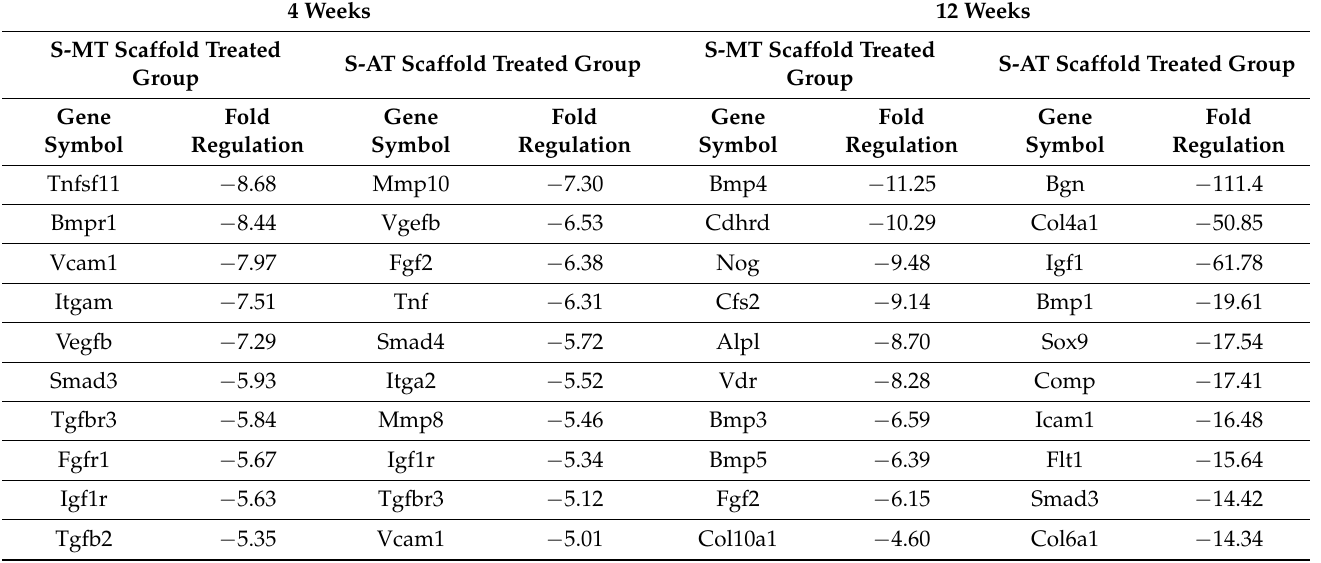
Table A2. Fold regulation of the expression of the top 10 downregulated genes for each group and time point of